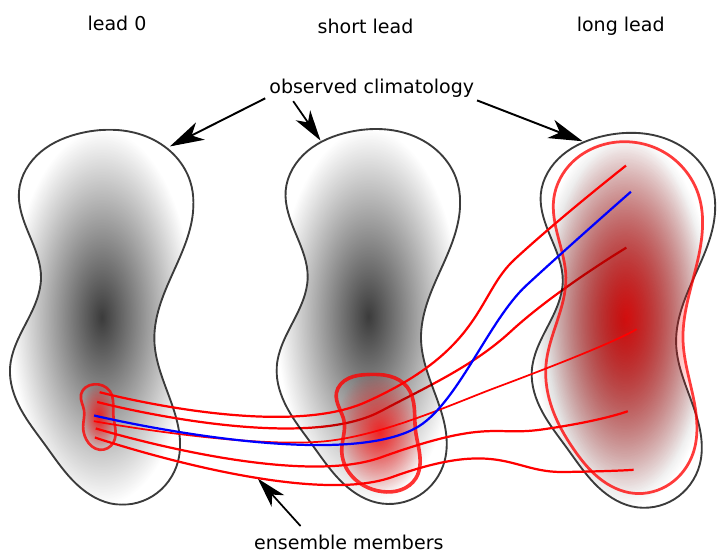
Figure 2. Schematic of a forecast ensemble without biases. At lead 0, the forecast members (red) are initialised close to observations (blue). At short lead times (middle panel), the forecast ensemble members have spread somewhat (within the space enclosed by the red line), but still span only a part of the whole climatological space of observations (spanned by the black line). At sufficiently long lead times, the forecast has lost skill and the ensemble members now effectively span the whole climatological space of observations (red and black lines nearly